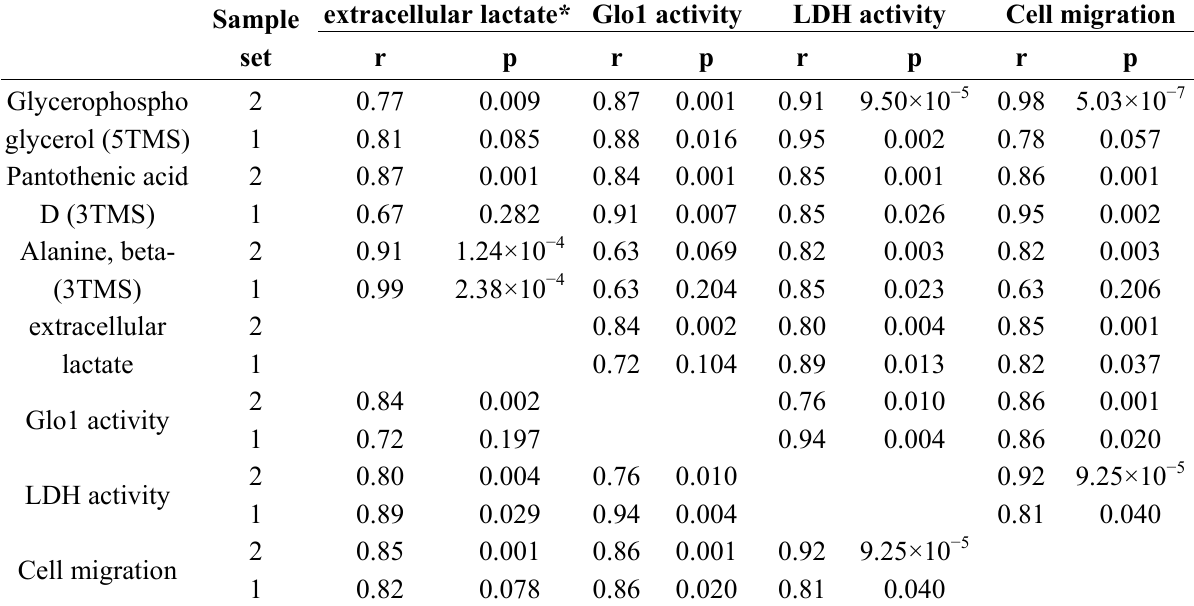
Table 3. Pearson’s correlation between extracellular lactate, Glo1 and LDH activity, number of migrated cells (migration) and relative metabolite intensities for the five breast cancer cell lines (sample set 1), and for the breast cancer cell lines and an Glo1 knockdown mutant MCF-7siGlo1 and the corresponding mock transfected control cells of the cell line MCF-7, MCF-7 mock (sample set 2). The dataset was calculated on basis of mean values, n = 6 for the metabolite profiles and Glo1 activity per cell line, n = 5 for cell migration, n = 4 for LDH